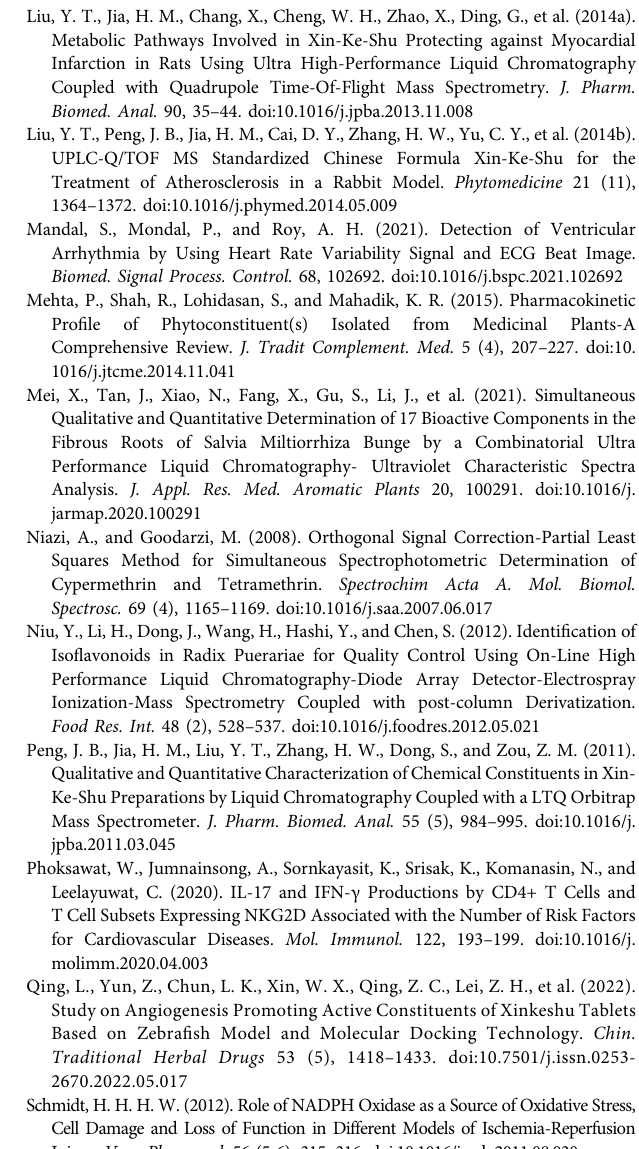
Supplementary Figure S1 | Plasma peak area versus time pro fi les for constituents after the oral administration of XKST in male rats. The order of peak appearance is based on the sum of plasma peak area at each time point. Each point represents an average of six determinations, and the error bars are the standard error of measurement ( n = 6). Supplementary Table S1 | Precisions, stability, repeatability and recovery rate of fi ve